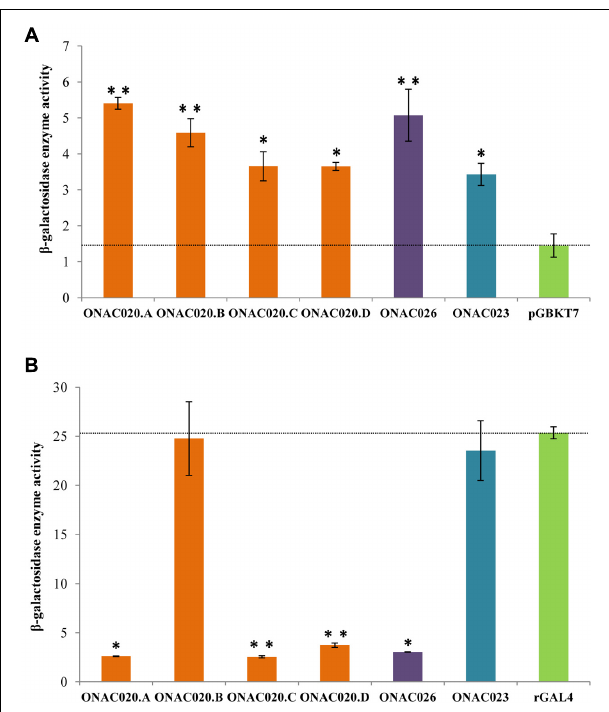
FIGURE 5 | Transcriptional ability of the NAC TFs by (A) transactivation and (B) transrepression assays of the three NAC proteins, and the proteins generated by trans- splicing of ONAC020/ONAC026 (i.e., ONAC020.B–D). The graphs show the relative β -galactosidase activity of the NAC TFs by the ONPG assay on the Y -axis. The vector pGBKT7 is the negative control for transactivation assays in (A) and the reconstituted GAL4 TF (rGAL4) is the positive control for transrepression assays in (B) . The standard error bars have been shown. The values which are significant with a P -value cut off ≤ 0.05 and ≤ 0.005 are indicated by a single and double asterisks, respectively.